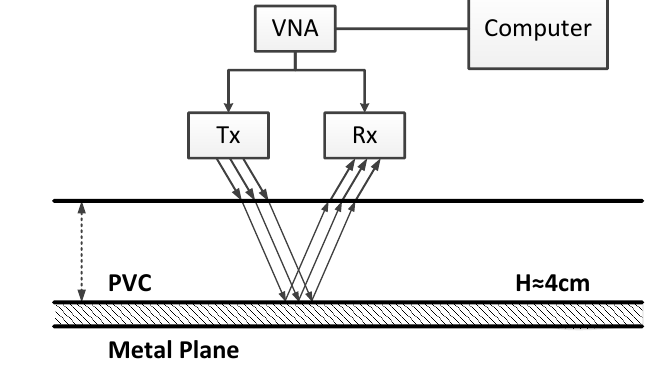
Figure 13. Experimental setup.